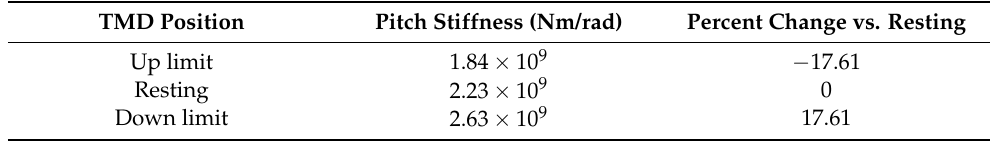
Table 23. Change in pitch stiffness with TMD motion. TMD Position Pitch Stiffness